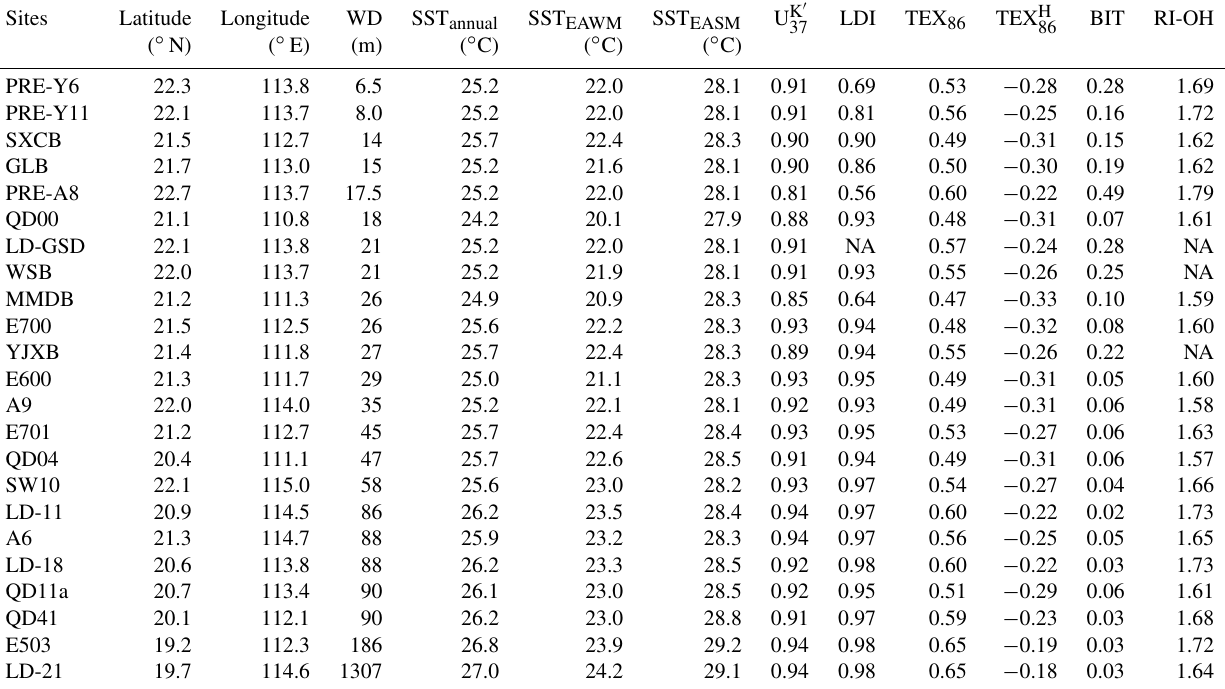
Table 1. Sampling sites, SST and proxy values from the PRE and northern SCS shelf (water depth – WD, sea surface temperature – SST – obtained from WOA18, ring index of OH-GDGTs – RI-OH).